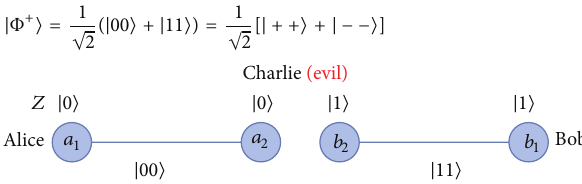
Figure 13: The scenario of participant attack 1 in which Charlie (controller) steals the secret messages by the nonlocal swap gate scheme.